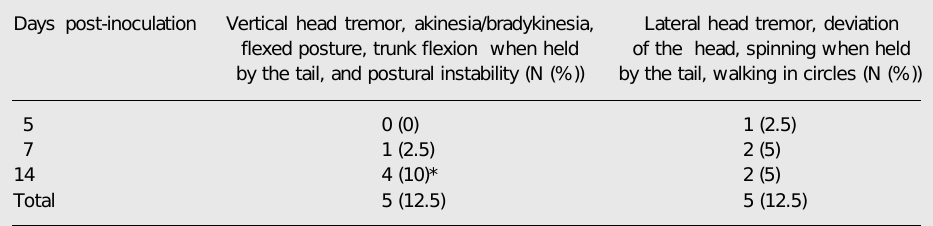
Table 1. Neurological manifestations observed in 40 mice inoculated with 5 x 10 6 log phase CFU of Nocardia otitidiscaviarum